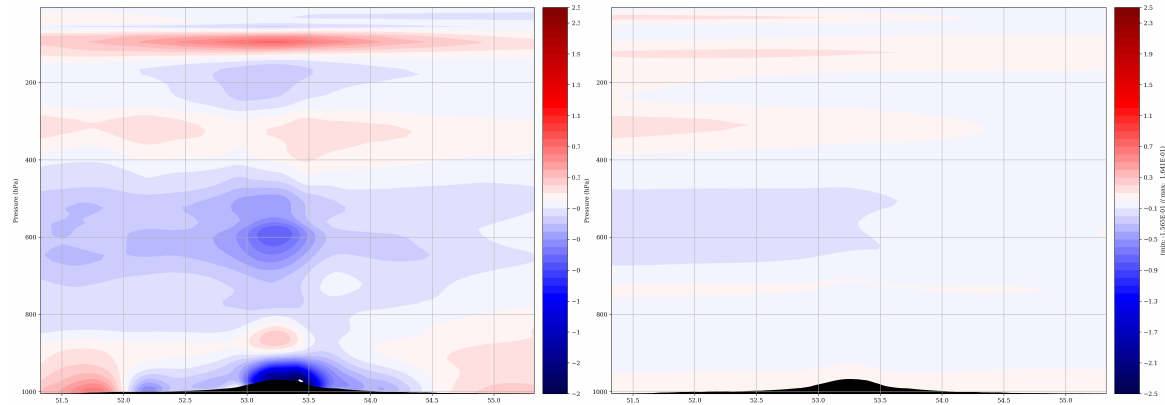
Figure 11. Temperature analysis increment on zonal section (51°3 E–55°3 E, 12°2 S) across TC center on 7 February 2019 02:00Z for SAR_12km_2ms ( left ) and NO_SAR ( right ). Units are K.